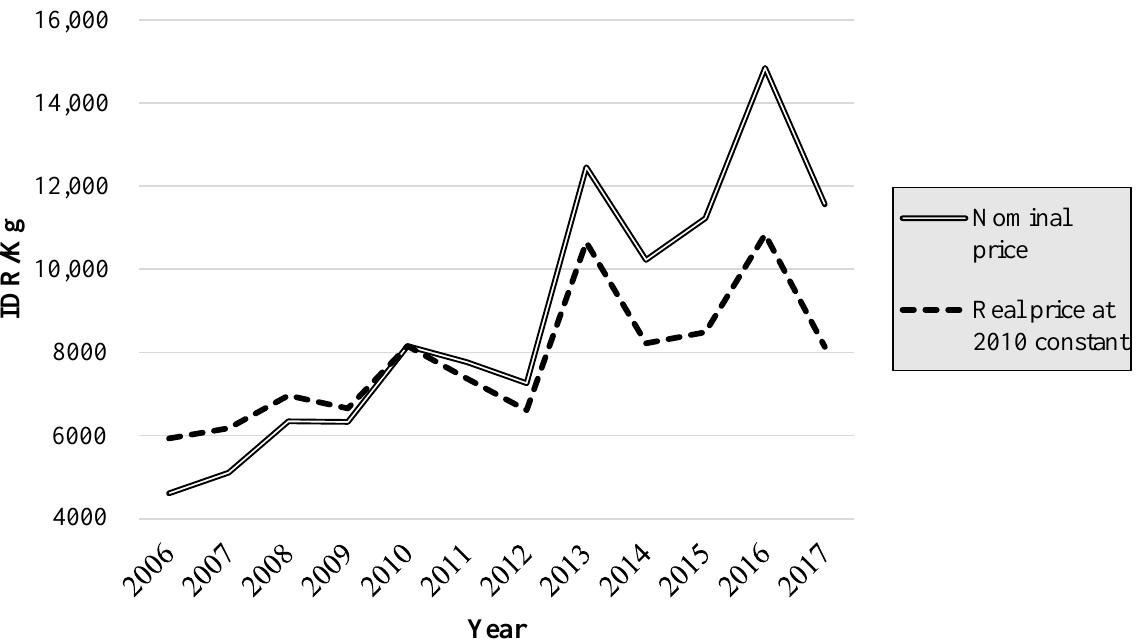
Figure 1. Trends of wholesale market prices in Jakarta in 2006–2017. The daily price data of eight main commodities (Chili, Cabbage, Red onion, Tomato, Potato, Carrot, Eschalots, Wombok) were obtained from an officer of the Kramat Jati wholesale market. Note that we calculate the yearly average price as total sales of the eight main commodities divided by the total amounts each year. The real price is derived by using the World Bank CPI (https://data.worldbank.org/indicator/fp.cpi.totl?end=2017&start=1960&view=chart, accessed on 1 May 2019). IDR is an abbreviation of Indonesia Rupiah. The average exchange rate for the recorded period is 10,723 IDR for 1 US dollar (calculated by the selling exchange rate data from Bank Indonesia).